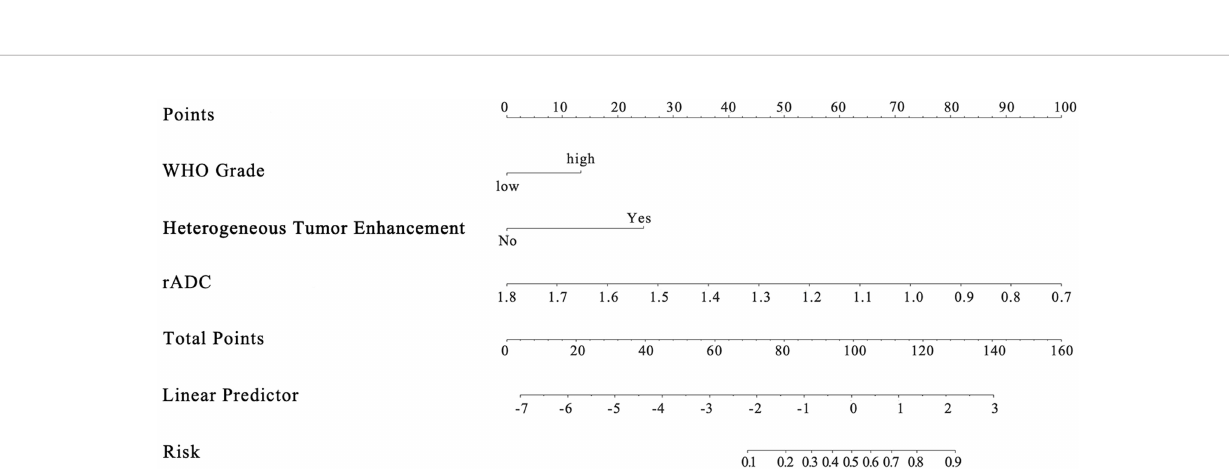
FIGURE 3 | The novel algorithm nomogram for predicting postoperative recurrence of